Question: In a single sentence, describe what this figure presents.
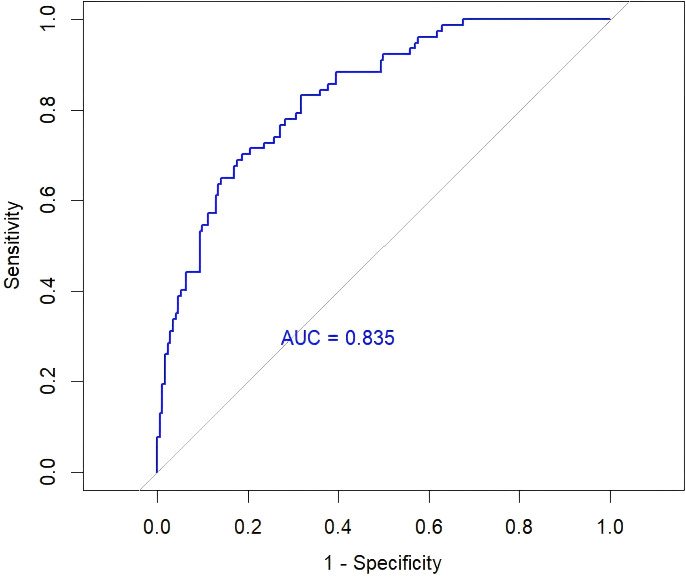
Answer: ROC curve of the prediction model. ROC, Receiver operating characteristic; AUC, the area under the ROC.